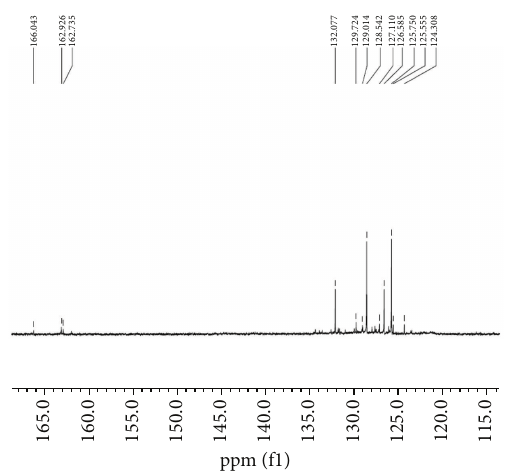
Figure 6: Aromatic region of 13 C NMR spectrum of C 1 R 󸀠 RuPc .